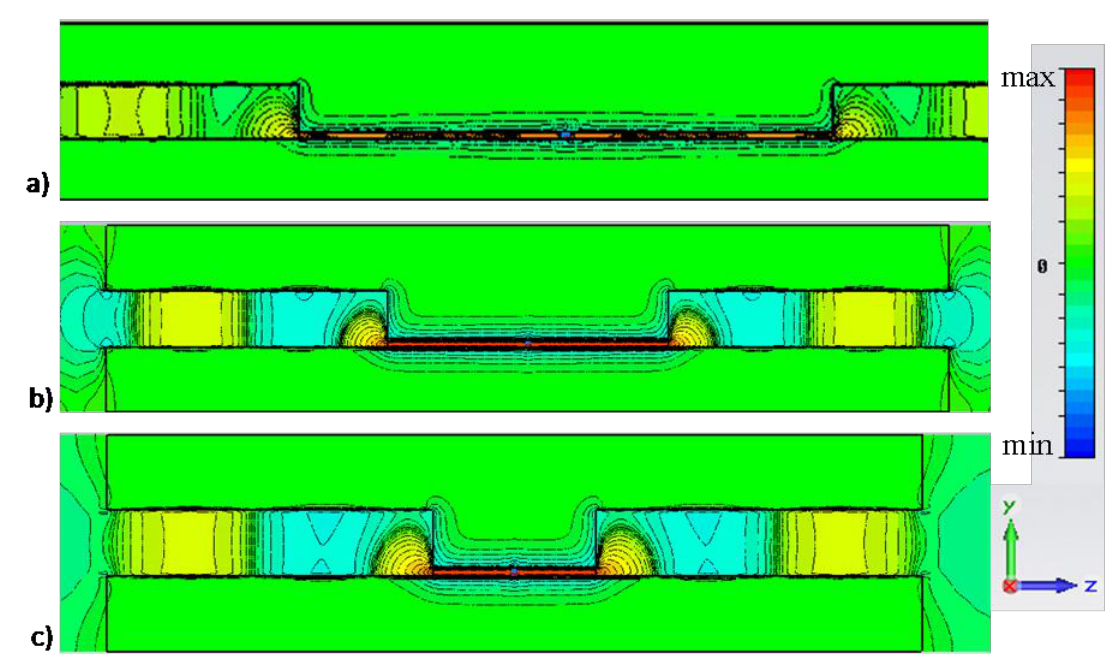
Figure 5. Simulation results for side view of the electric field distribution time) for a molecule emitting in the center of the narrow channel of Figure 1 at the